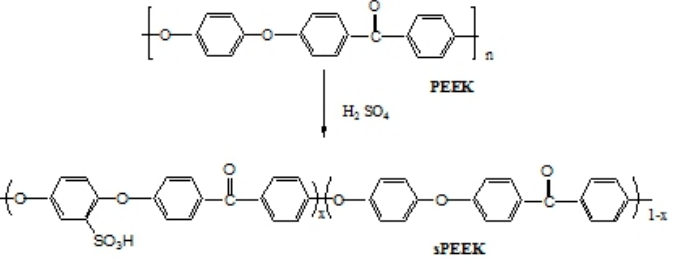
Figure 1. Chemical structures of polyether ether ketone (PEEK) and sulfonated PEEK(sPEEK) in the sulfonation reaction.